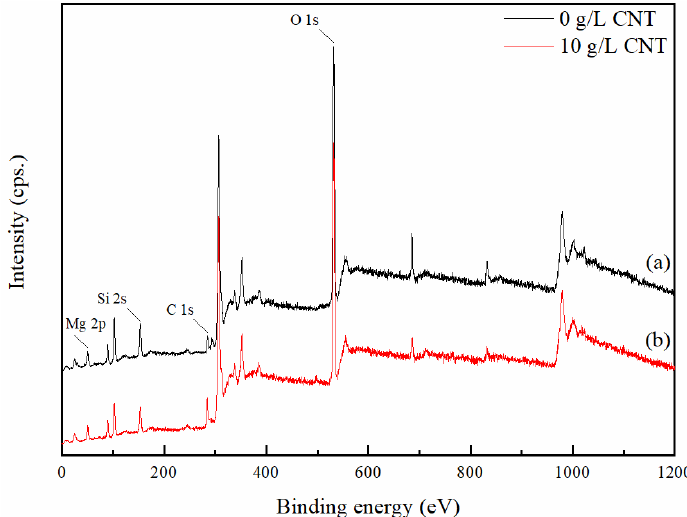
Figure 7. X-ray photoelectron spectroscopy (XPS) spectra of the PEO coatings in an electrolyte containing different concentration of CNT: ( a ) 0 g/L CNT; ( b ) 10 g/L CNT.